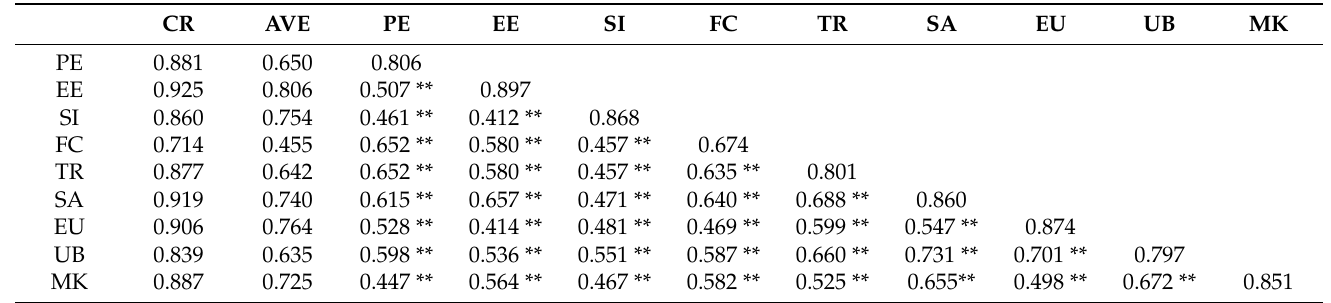
Table 5. Descriptive statistics and correlation